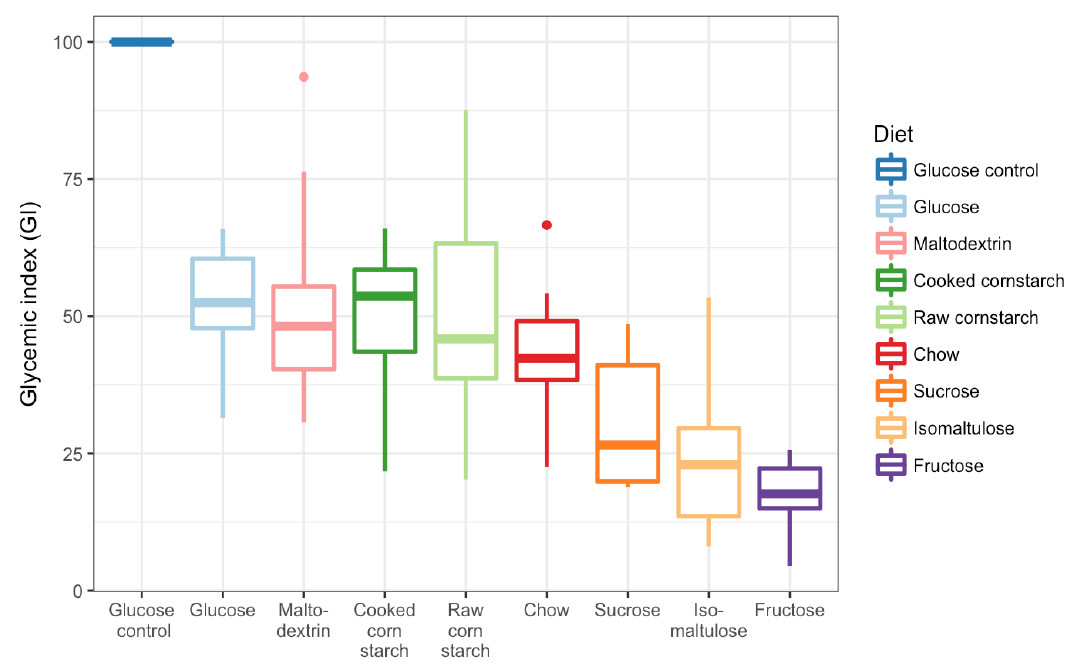
Figure 4. Boxplot of glycaemic index of eight diets (all ~60% carbohydrate as energy) differing in type of carbohydrate and glucose control. n = 10 female mice for each diet. Nutrients 2018 , 10 , x FOR PEER REVIEW